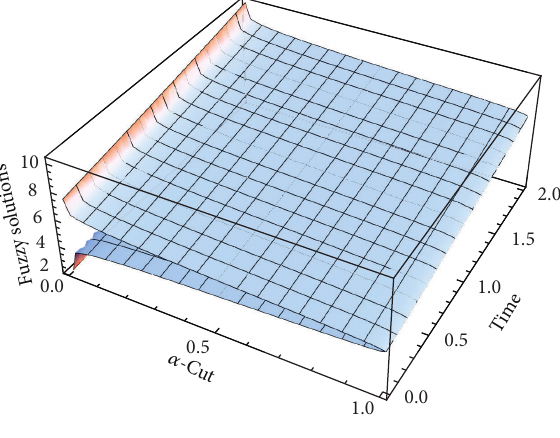
Figure 3: Fuzzy solution at 𝑟 = 25 of Case 3.